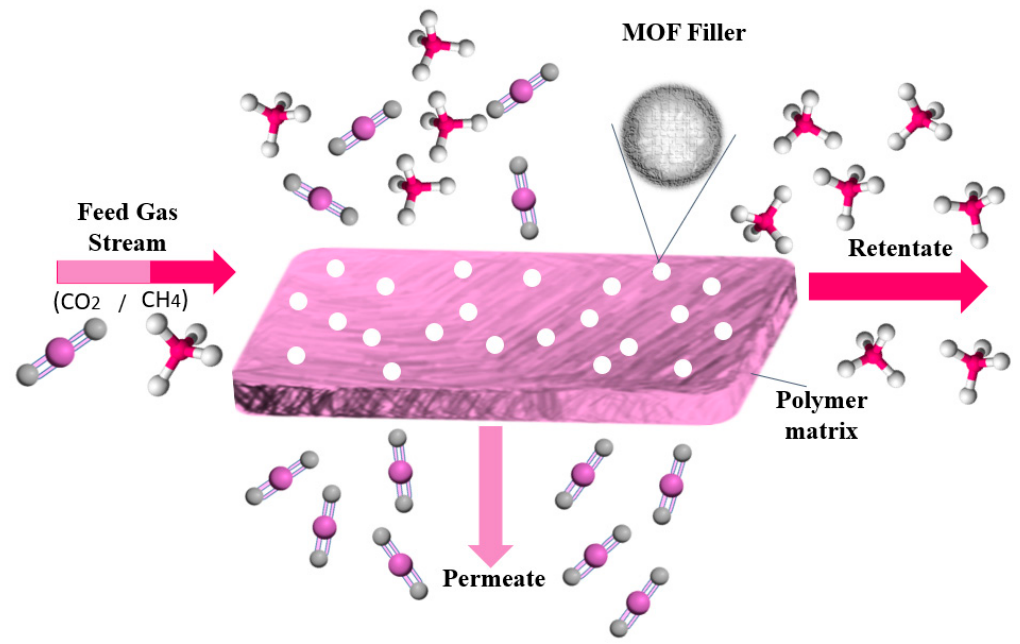
Figure 6. MOF-based mixed matrix membrane (MMM) for CO 2 capture.